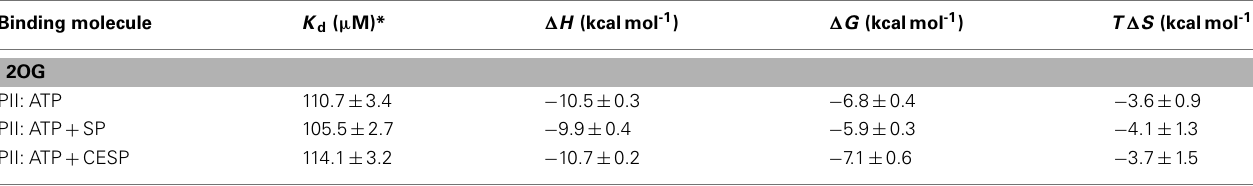
FIGURE 5 | Overview of the MapMan visualization of differences in transcript levels between control samples and SP-treated samples. Genes associated with metabolic pathways were analyzed by the MapMan software (http://mapman.gabipd.org/web/guest/mapman). Blue and red represent a decrease and an increase of expression, respectively, in the